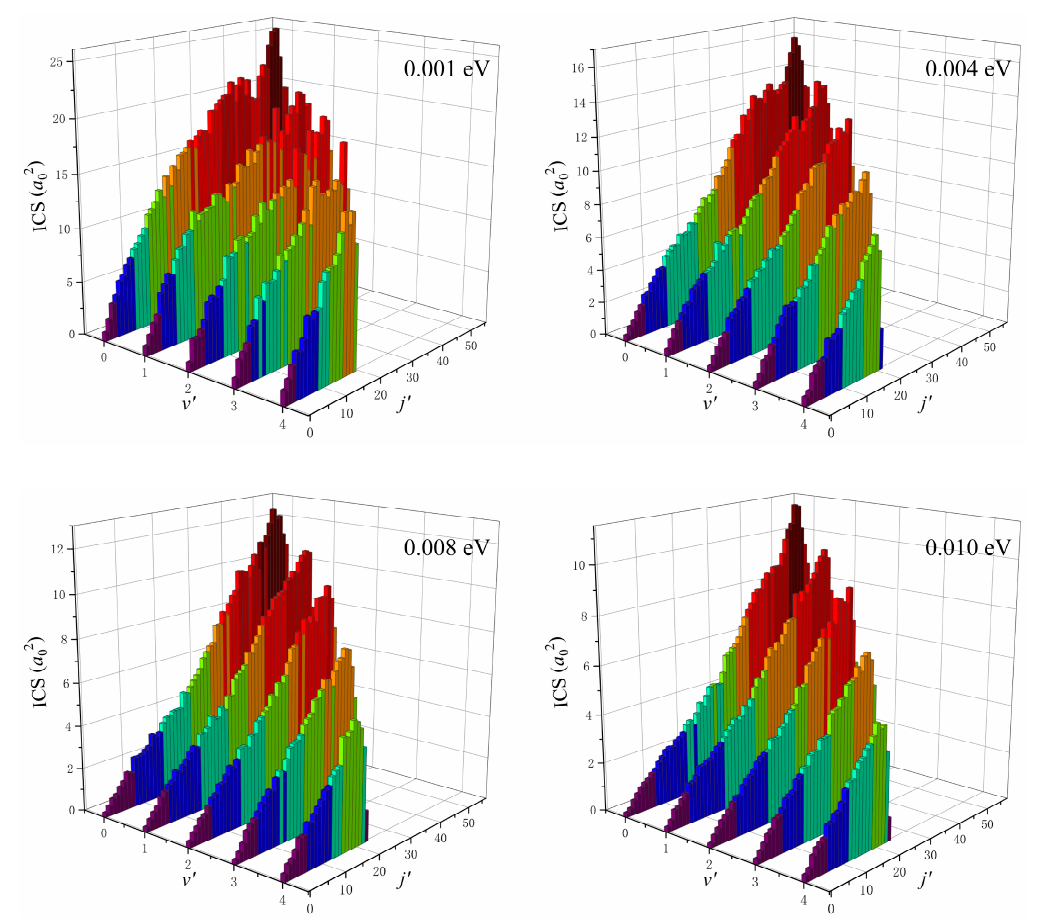
Figure 8. Rovibrationally state-resolved ICSs of the product LiNa molecules of the Li( 2 S) + Na 2 ( v 0 = 0, j 0 = 0) → LiNa + Na reaction at four collision energies (0.001, 0.004, 0.008 and 0.010 eV) calculated by the improved TDWP method on the GP PES.